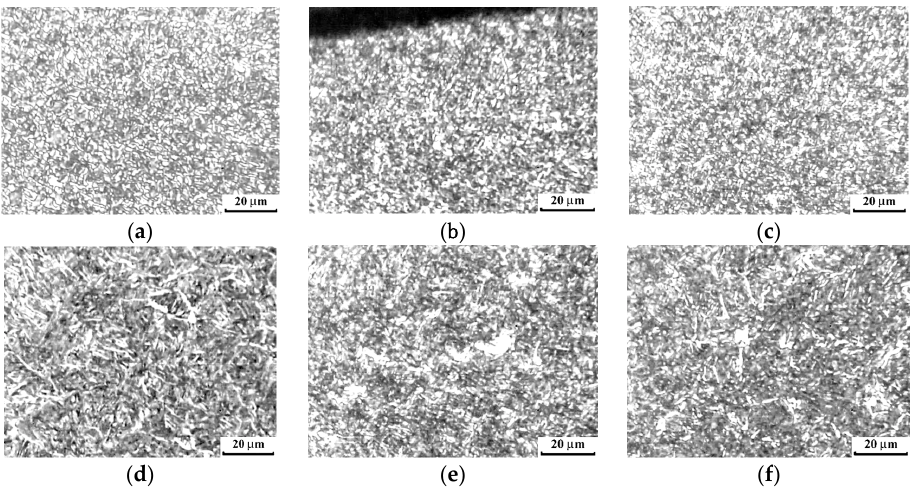
Figure 5. Microstructure of Ti-Al-Mo-V alloy at the Φ 20 → Φ 16 mm transition. From left to right: samples 1, 3, and 5 (see Figure 1); ( a – c ) surface structure; ( d – f ) structure at the central part of the rod.